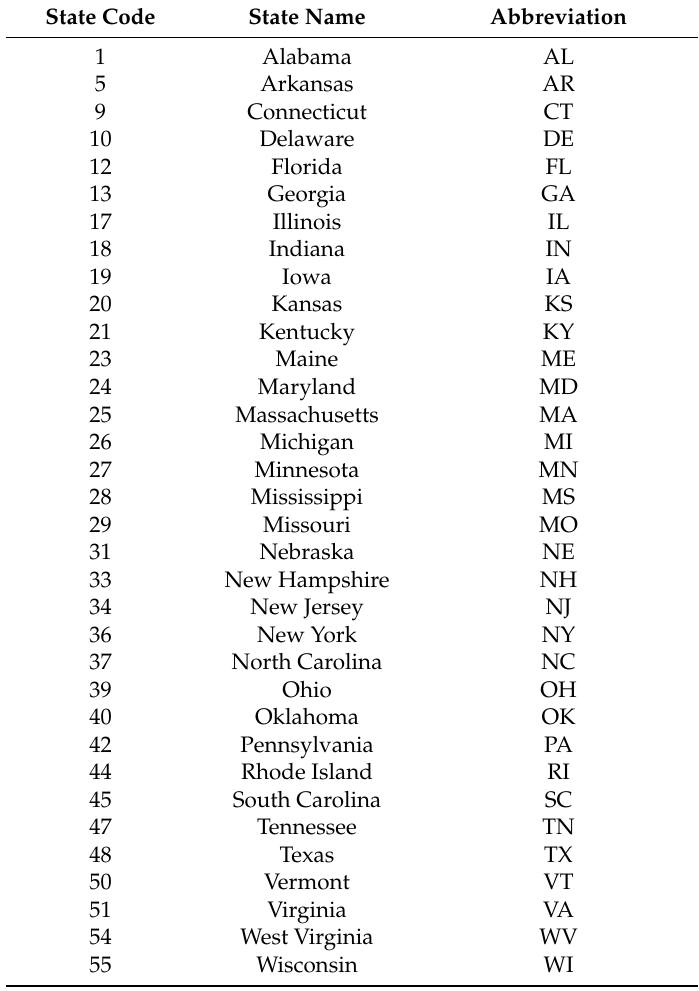
Table 1. State Codes in the USDA Forest Service Forest Inventory and Analysis Database (FIADB) for the States used in this